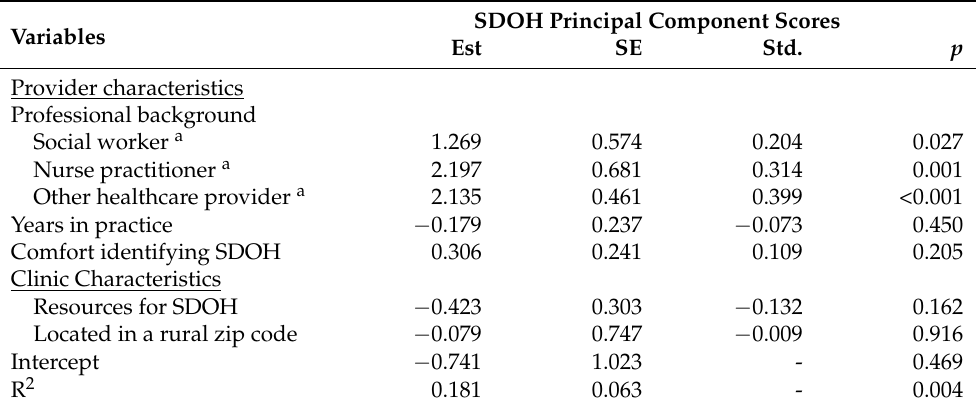
Table 3. Results of linear regression examining differences in healthcare provider reports on the portion of patients experiencing social determinants of health (SDOH).